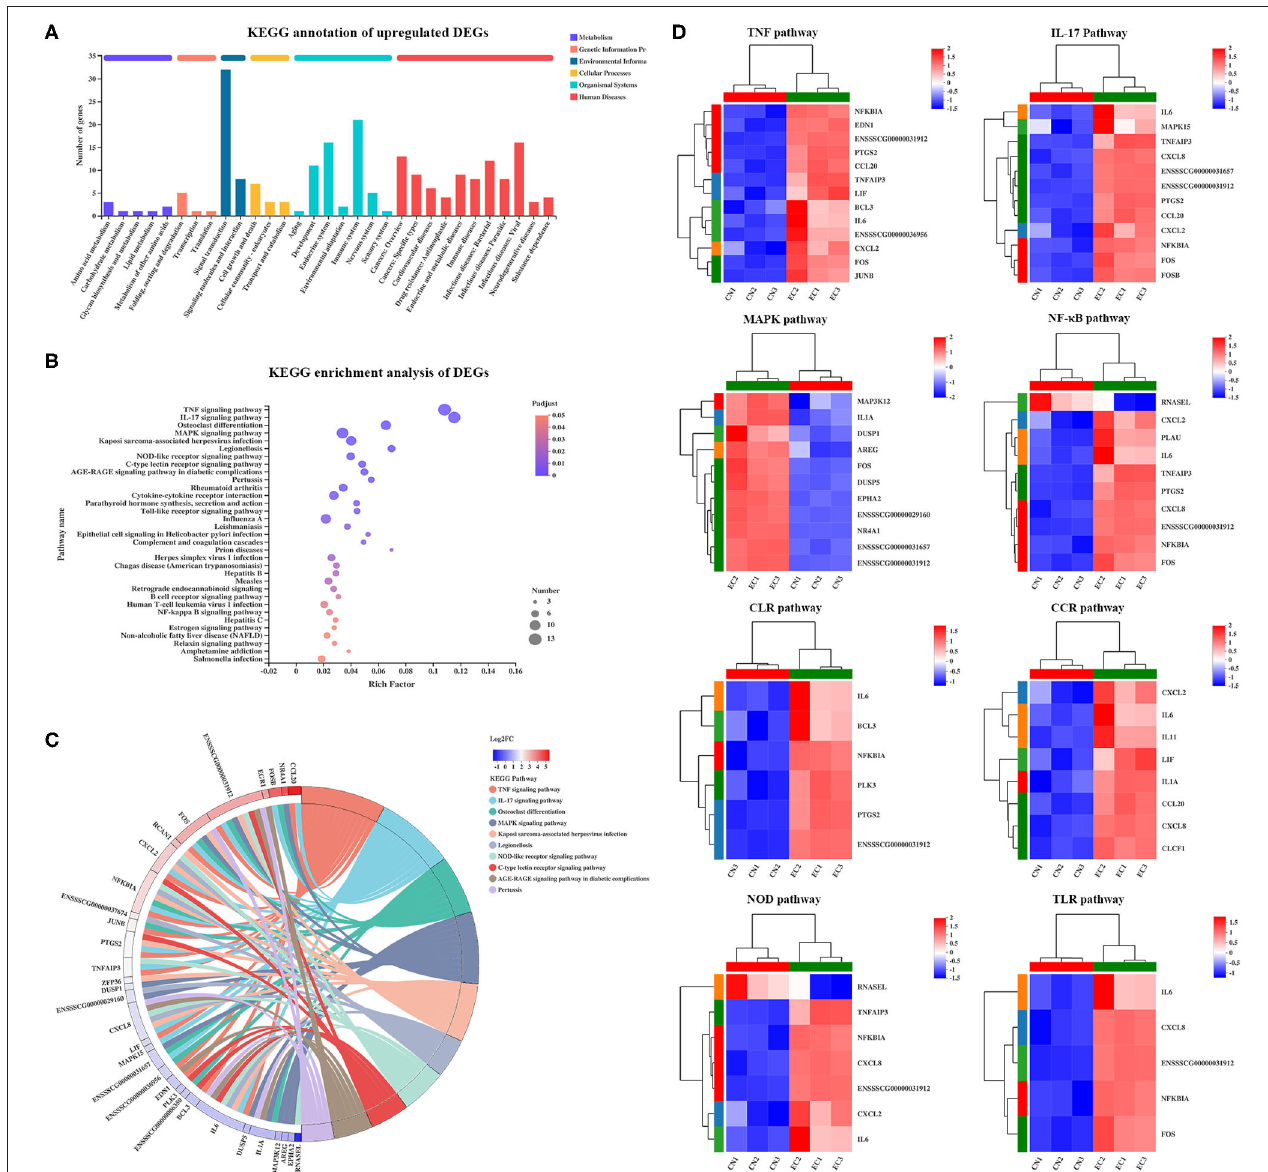
FIGURE 6 | KEGG enrichment analysis of DEGs. (A) KEGG pathway annotation of DEGs. (B) KEGG enrichment analysis of DEGs. Enriched bubble chart showing enrichment of KEGG pathways. X-axis represented enrichment ratio, and Y-axis represented top 20 KEGG pathways. Number: Bubble size represented number of genes annotated to a KEGG Pathway. Padjust: color indicated enriched adjusted p -value. (C) KEGGChord plot of top 10 ranked KEGG pathways. Chords indicated a detailed relationship between expression levels of DEGs (left semicircle perimeter) and their enriched KEGG pathways (right semicircle perimeter). Genes are linked to their annotated terms via colored ribbons. (D) Heatmap of DEGs enriched in immune response-related KEGG pathways showing expression profile in CN and EC